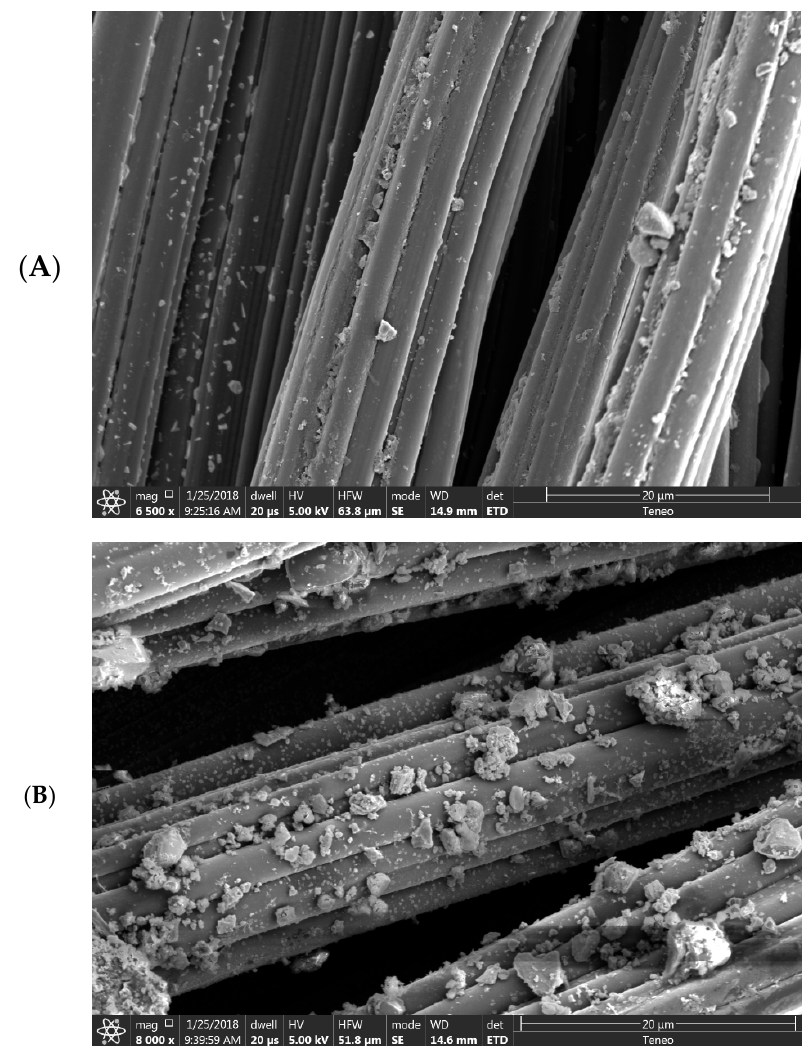
Figure 7. SEM images of ACFC from REM after passing E. coli solution (~10 4 CFU/mL) in 50 mM Na 2 SO 4 solution at 10 mL/min with ( A ) no voltage and ( B ) 10 V applied.